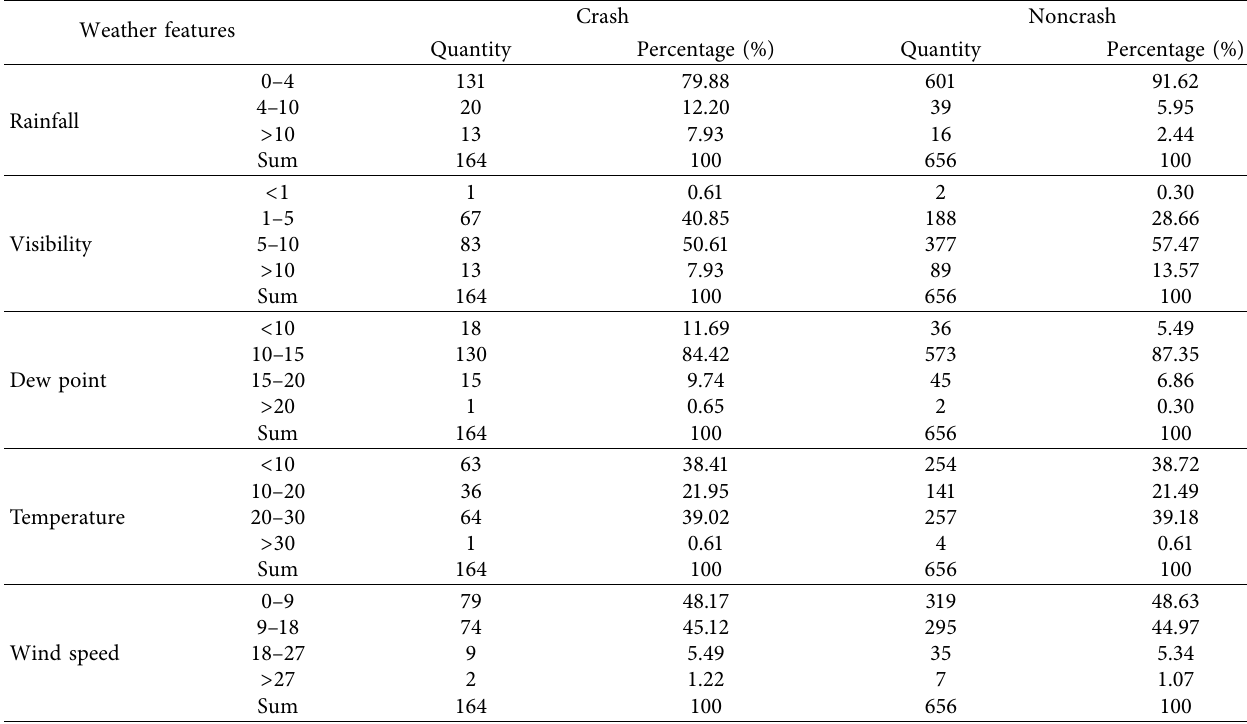
Table 6: Distribution of weather features in crash and noncrash